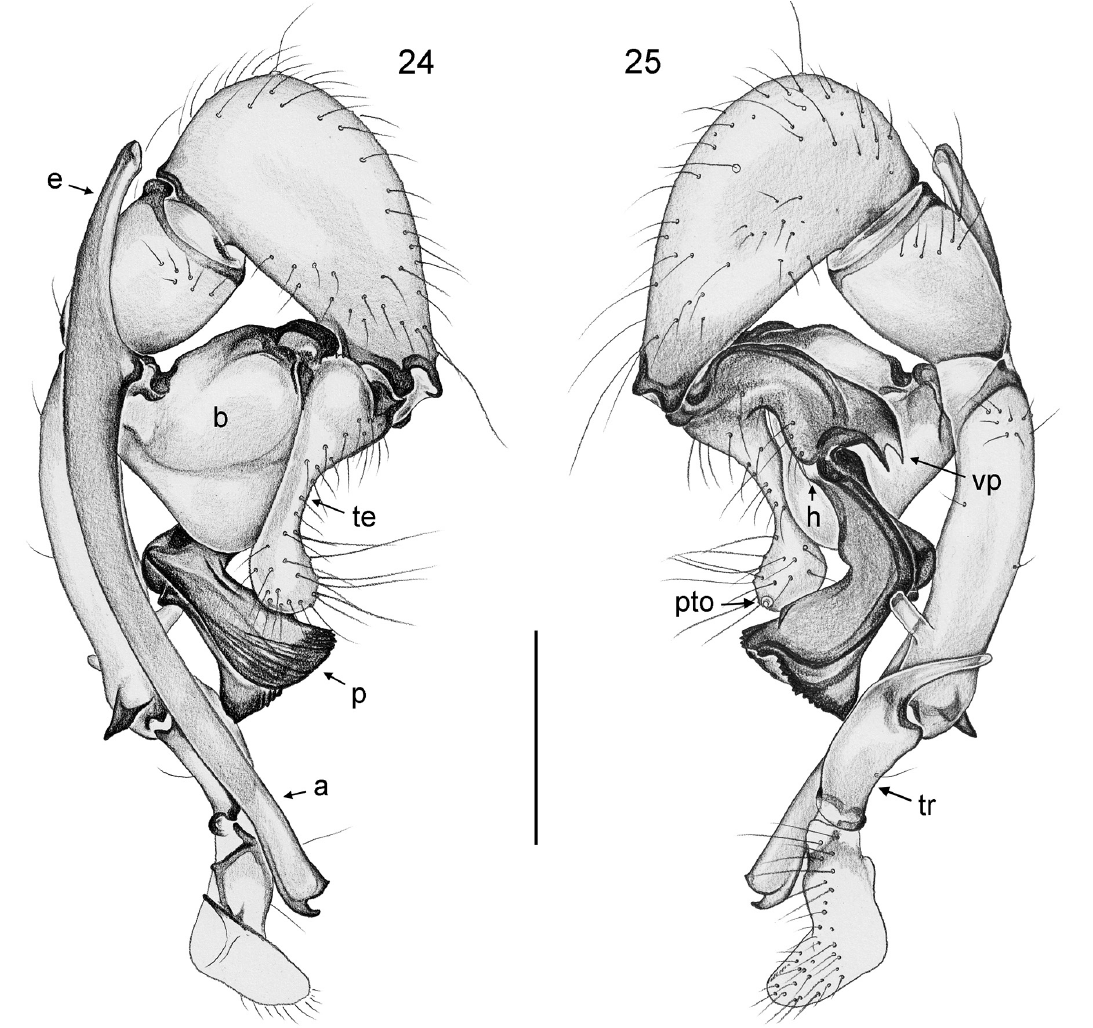
Figs 24–25. Panjange casaroro Huber sp. nov. (ZFMK, Ar 13001), left male palp, prolateral and retrolateral views. Abbreviations: a = appendix; b = genital bulb; e = embolus; h = hinge; p = procursus; pto = palpal tarsal organ; te = tarsal elongation; tr = trochanter; vp = ventral process. Scale bar = 0.5